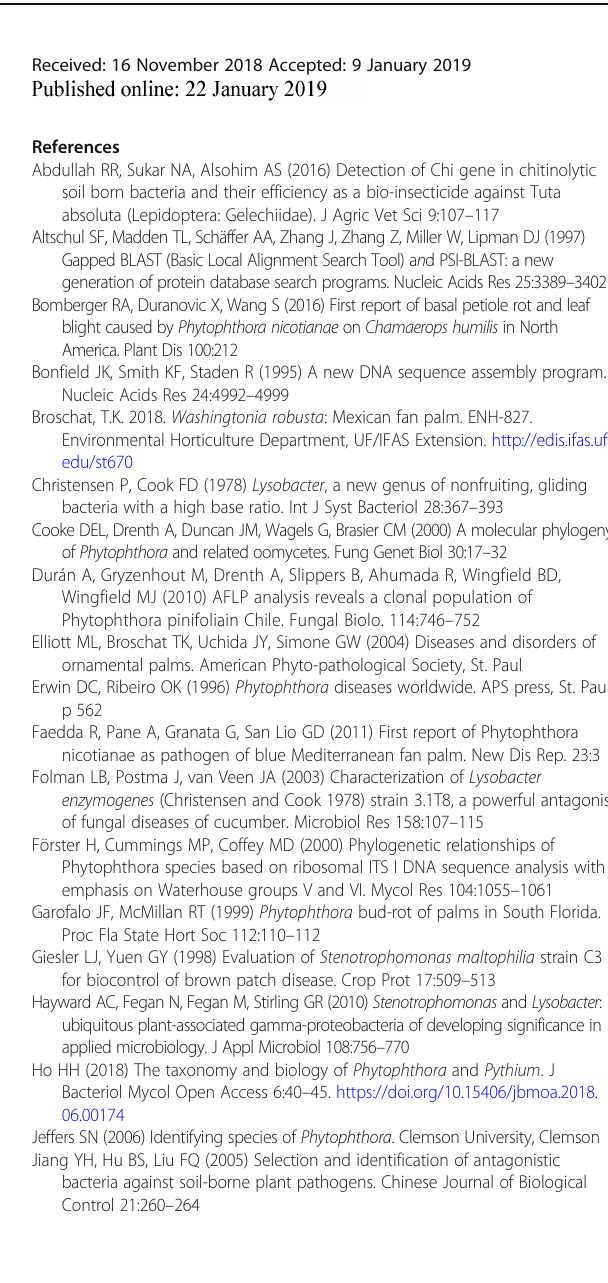
Fig. 10 Chitin hydrolysis by the bacterial isolate RN13 ( Lysobacter enzymogenes BB14) on CCA